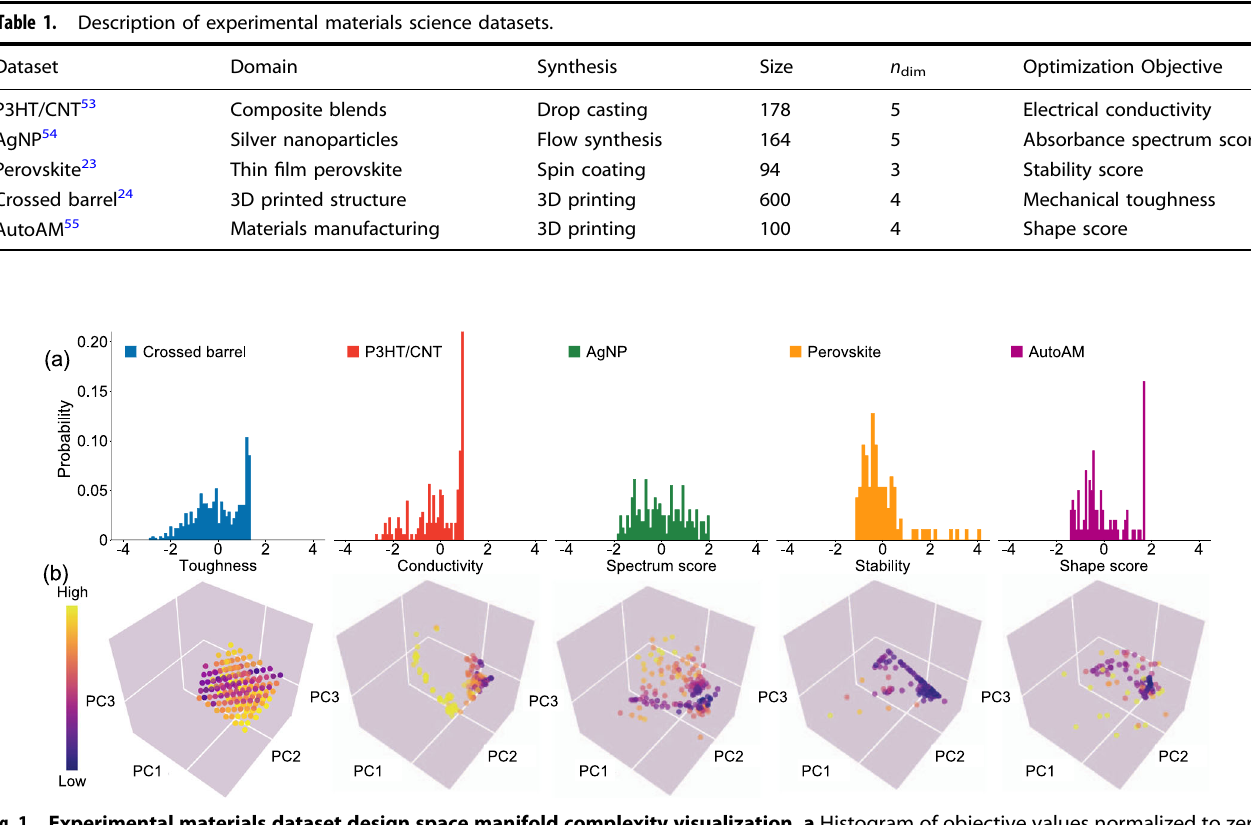
Fig. 1 Experimental materials dataset design space manifold complexity visualization. a Histogram of objective values normalized to zero- mean without loss of generality. b Input feature space, i.e. design space, visualization after dimensionality reduction to 3D via principal component analysis (PCA). The colors of each point in the datasets indicate its value. PCA was performed to reduce the dimension of each dataset to three for visualization, and the three axes shown are the top three principal component directions of each